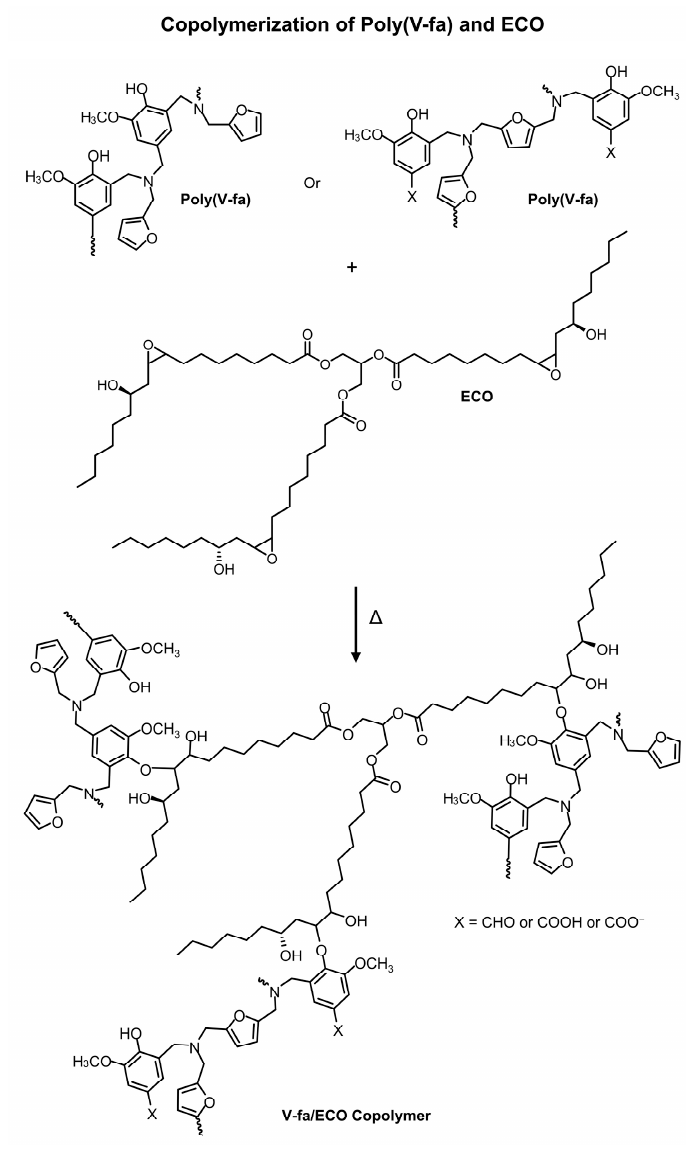
Figure 4. Copolymerization of poly(V-fa) and ECO.